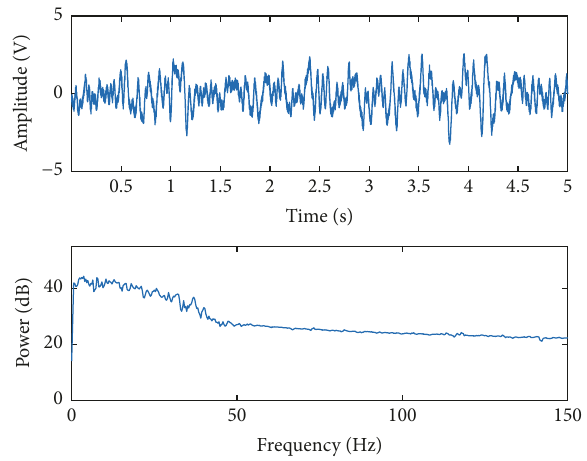
Figure 18: Received signal and power spectrum when the trans- ducer frequency is 50 Hz and flow meter value is 0.96